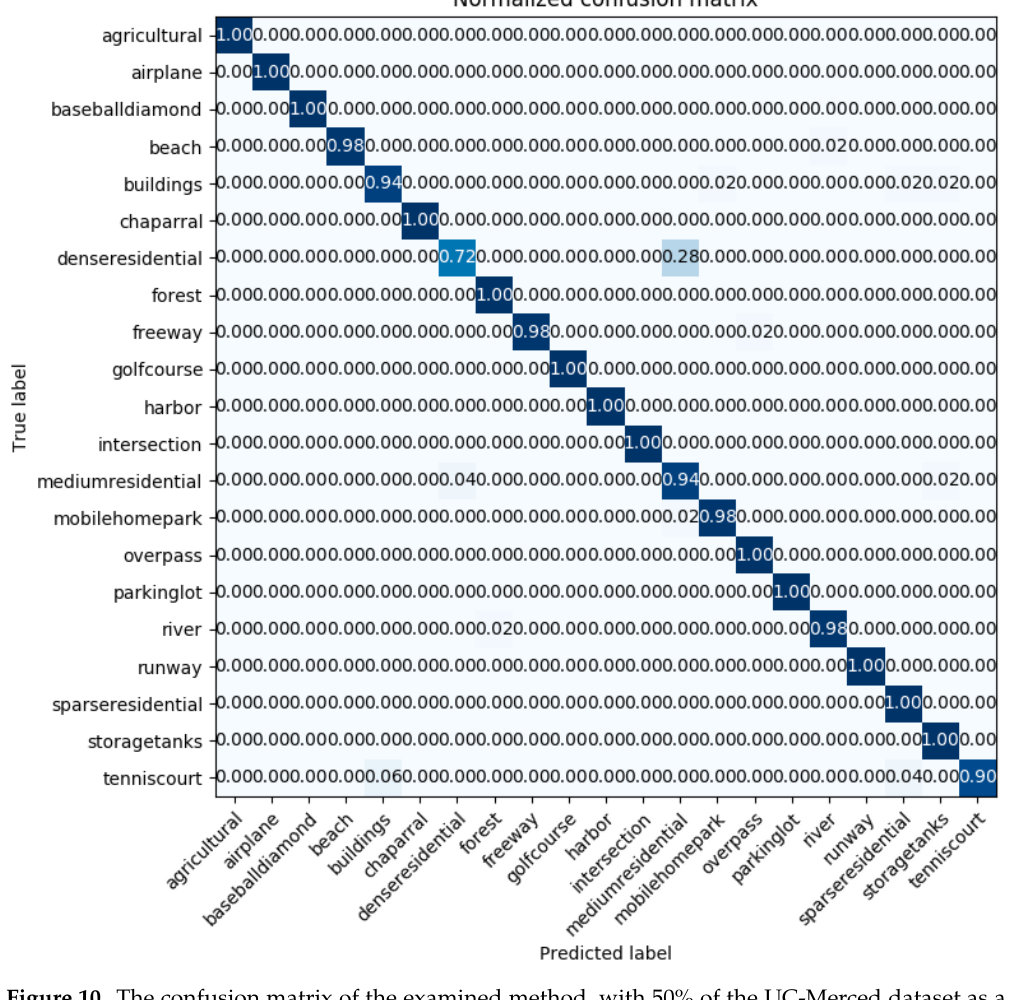
Figure 10. The confusion matrix of the examined method, with 50% of the UC-Merced dataset as a training set for InceptionV3 mixed_8 (PCA) + ResNet50 average pooling. The highlighting of the confusion matrix is a heat map, where white represents 0s, and dark blue represents 1s. Table 6. The classification accuracy (OA (%)) of the linear classification of fused features with PCA transformation, with 60% and 40% of WHU-RS dataset as a training